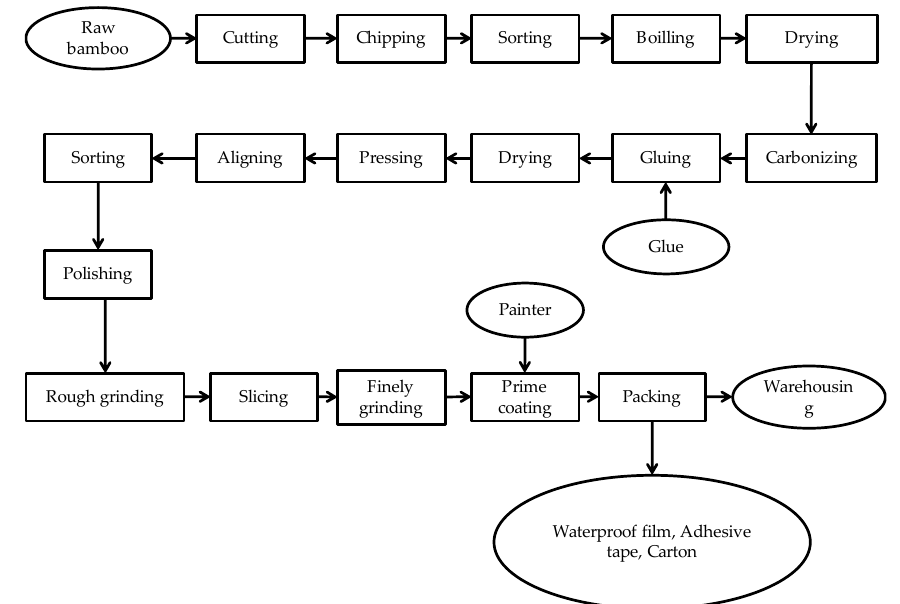
Figure 1. Procedure sketch for producing bamboo scrimber flooring.